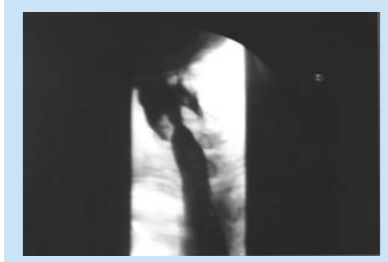
Fig. 3c. Anteroposterior study showing tra- cheal spill.